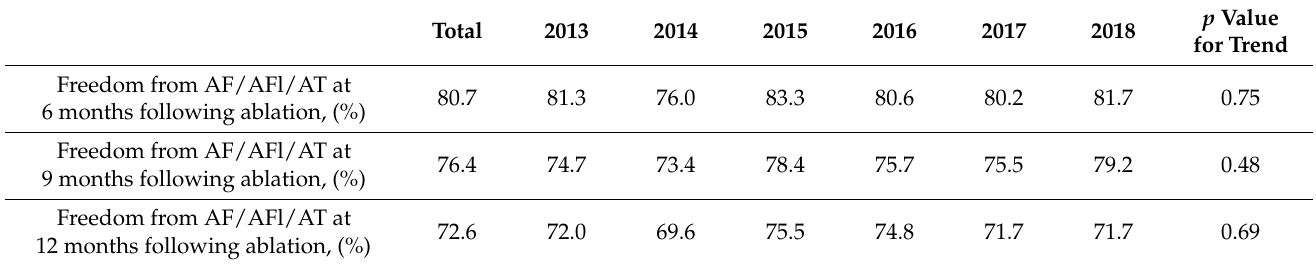
Table 3. Follow-up data showing freedom from AF at 6, 9, and 12 months after ablation.